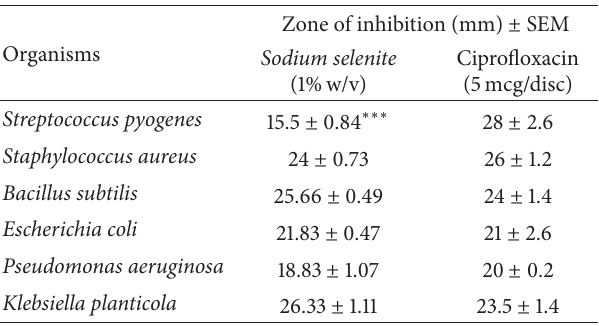
Table 2: Comparative study on the spectrum of activity among Gram positive and among Gram negative bacteria.